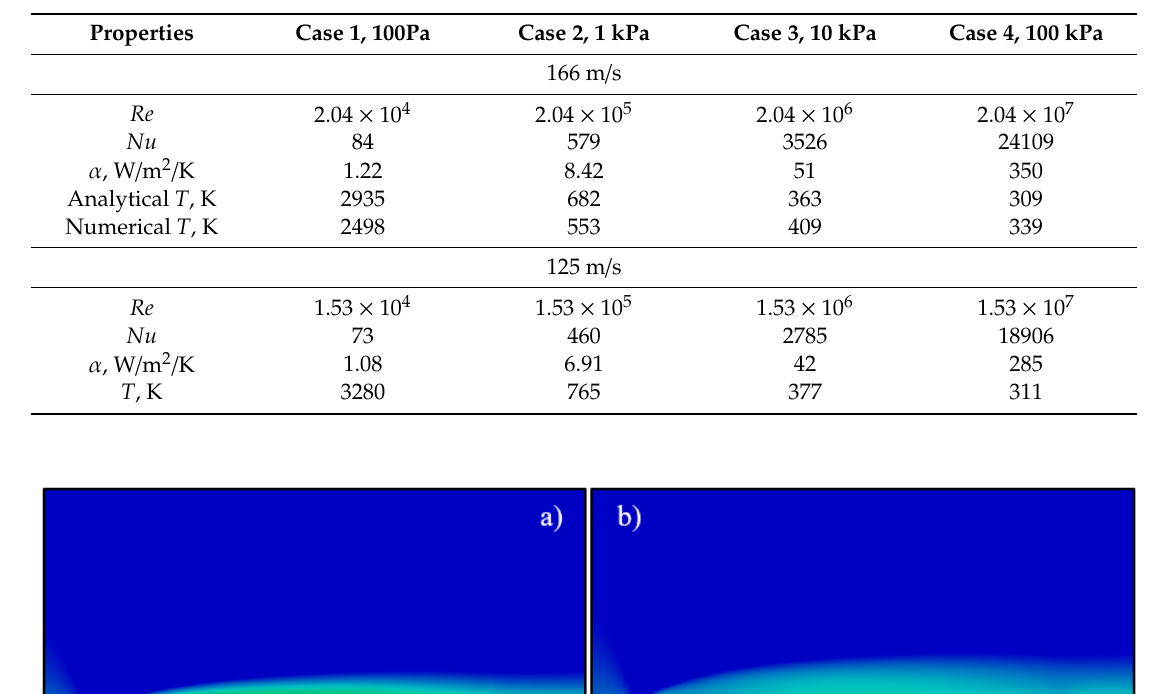
Table 2. Thermo-physical properties for 166 and 125m / s and comparison of analytical temperature results after cooling with numerical results for 166m / s.